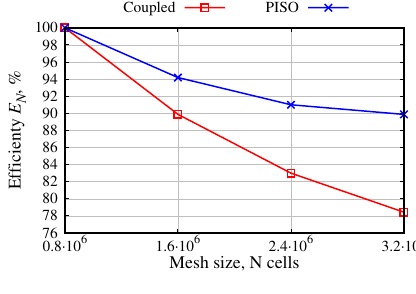
Figure 6. Weak scalability of parallel algorithms based on the coupled and PISO schemes solving the problem of flow through the aortic valve with increasing mesh size The measured results of the parallel tests show that the weak scalability of the considered parallel solvers is even better that the strong